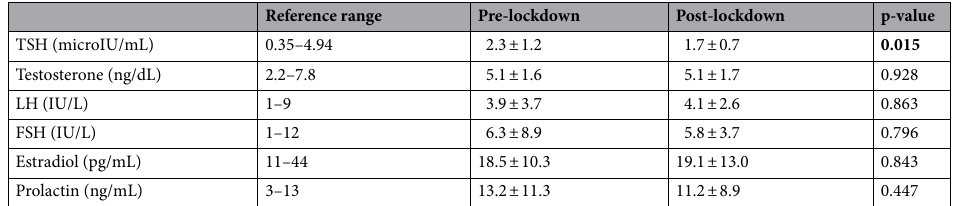
Table 2. Hormonal differences between pre- and post-lockdown evaluations. Data are expressed as mean ± standard deviation. Bold characters represent significantly different variables. FSH = follicle-stimulating hormone; LH = luteinizing hormone; TSH = thyroid stimulating hormone. The statistical comparison was performed by Mann–Whitney U-test.